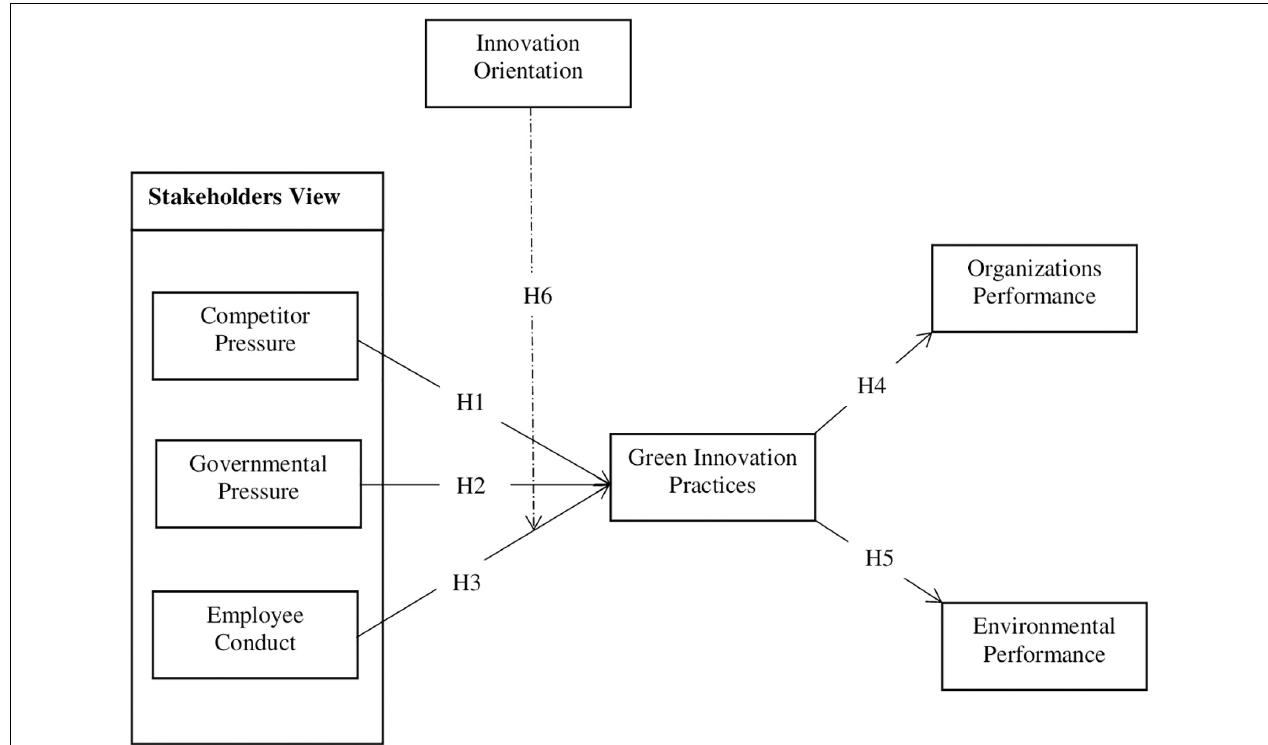
FIGURE 1 | Conceptual model of the